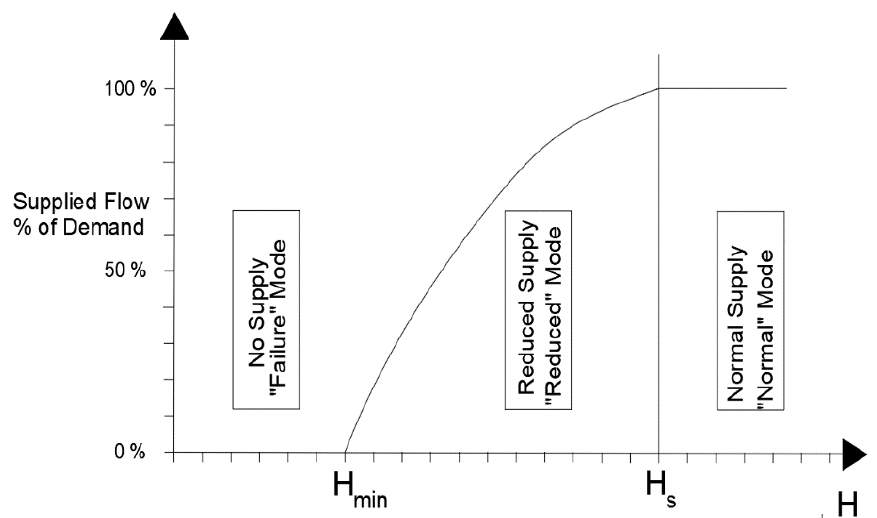
Figure 2. The relation among supplied flow and head at each node [28].